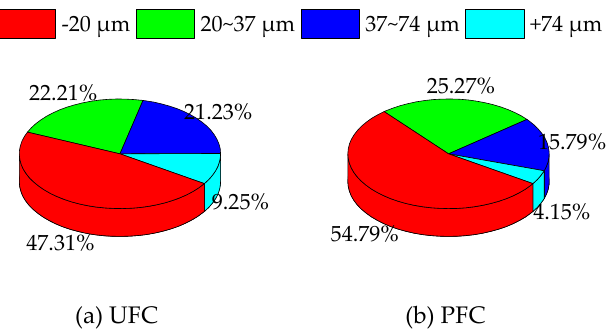
Figure 4. Particle size distribution of flotation concentrate by using ( a ) UFC and ( b ) PFC.